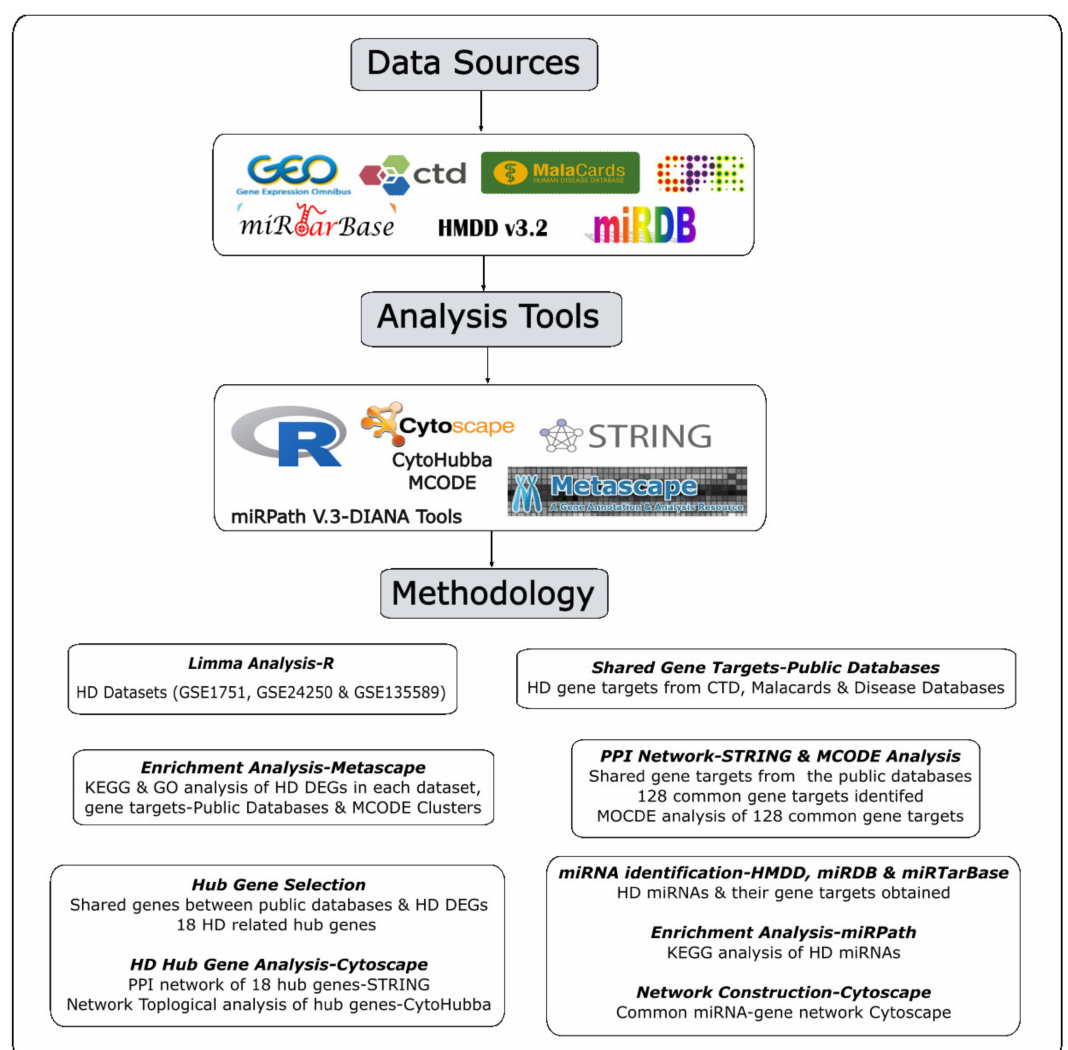
Figure 15. Workflow methodology applied in the